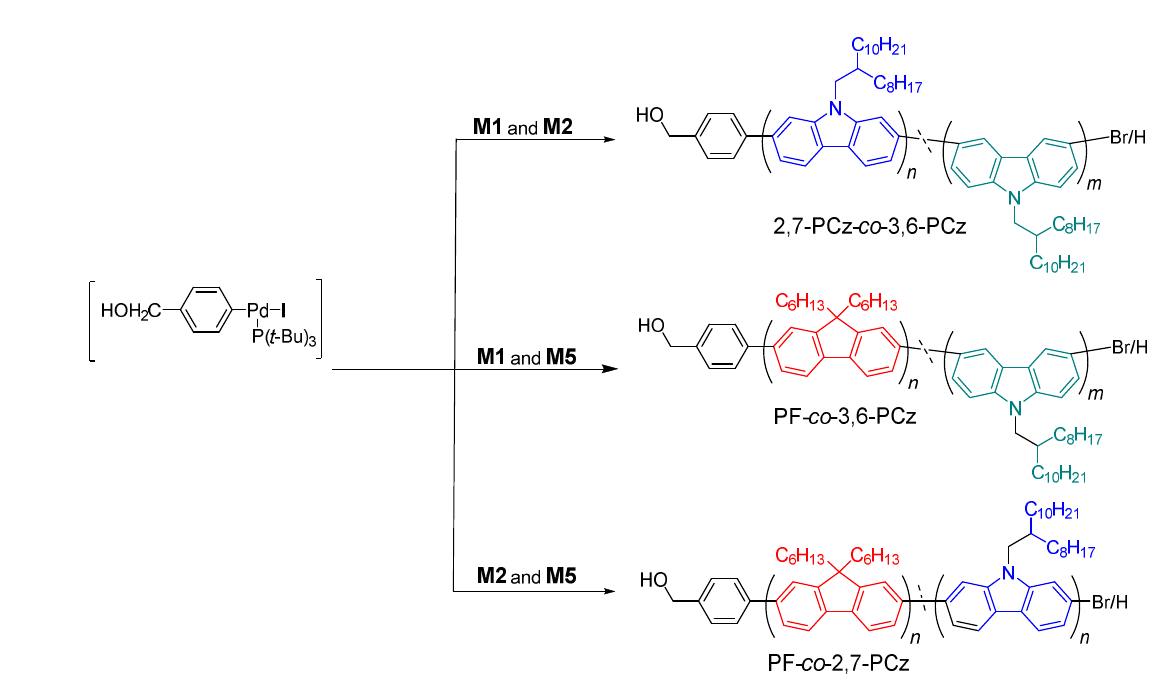
20.017.515.012.510.0 elution time (min) Figure 9. SEC traces of 2,7-PCz- co -3,6-PCz (black curve), Figure 9. SEC traces of 2,7-PCz- co -3,6-PCz (black curve), PF- co -2,7-PCz (red curve), and PF- co -3,6-PCz PF- co -2,7-PCz (red curve), and PF- co -3,6-PCz (blue curve). (blue Table 2. Synthesis of PCz and PF-containing random copolymers. a.